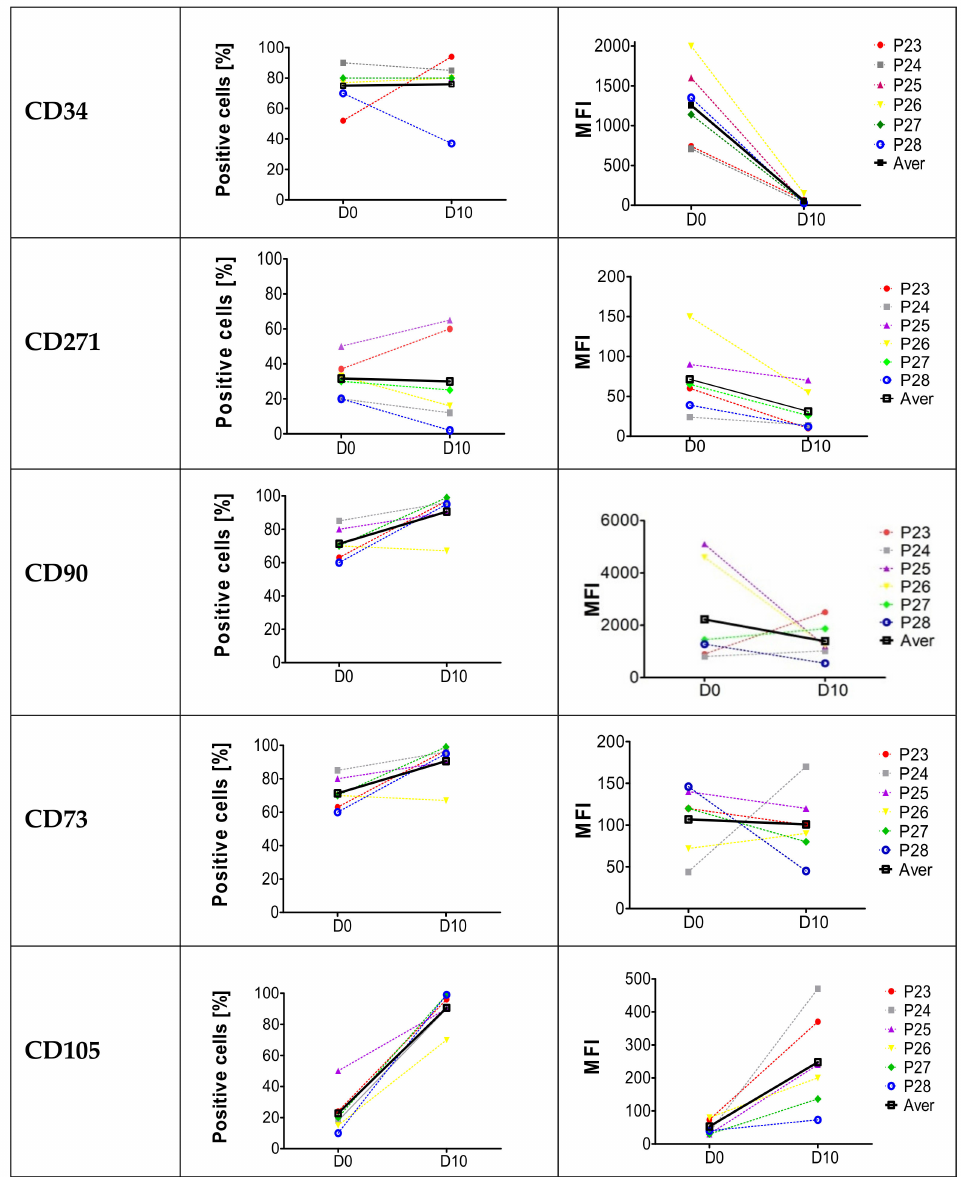
Figure 1. Phenotypic analysis of freshly isolated MSCs and cells after 10 days of culture. Percentages of CD34, CD271, CD90, CD73 and CD105 positive cells and antigen expression level (MFI) in freshly isolated cells and after 10 days cultures were assessed using flow cytometry. The thick, black line represents the average